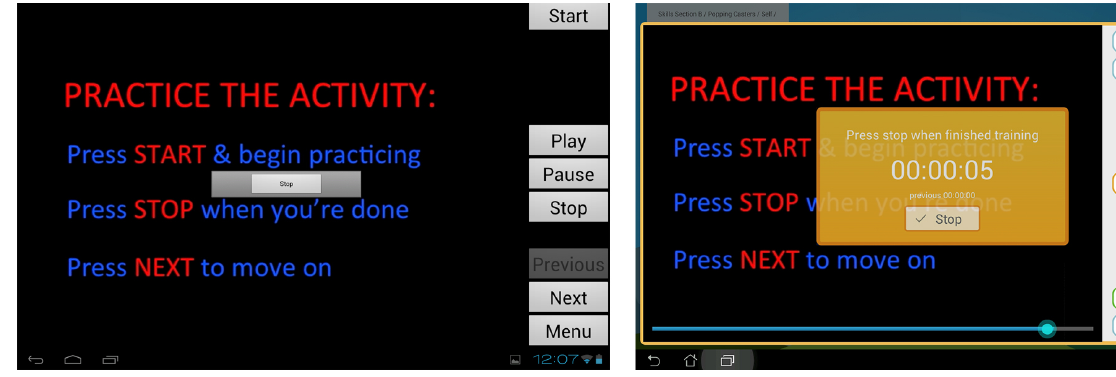
Figure 6. Training activity window with timer pre- and post-pilot versions.